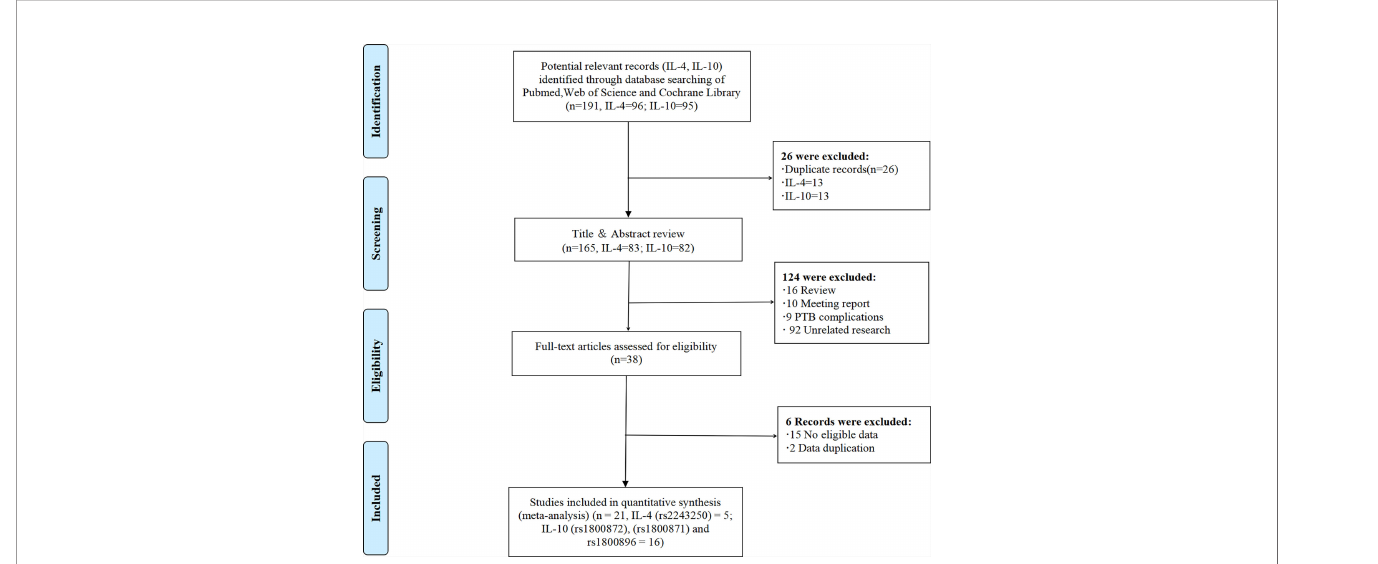
FIGURE 1 | The PRISMA fl ow diagram. PRISMA, Preferred Reporting Items for Systematic Reviews and